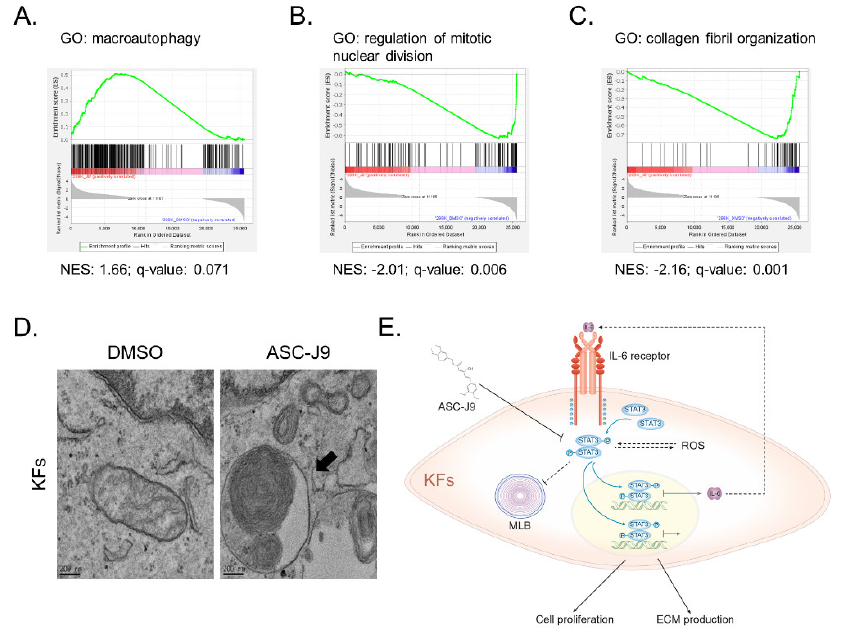
Figure 5. The formation of multilamellar bodies induced by ASC-J9 in keloid fibroblasts. ( A – C ) The biological pathways related to autophagy, cell proliferation, and ECM synthesis were identified by GSEA. ( D ) The structure of multilamellar bodies in KFs ( n = 3) treated with 10 μM ASC-J9 for 24 h was examined by TEM. ( E ) A proposed mechanism by which ASC-J9 affects the biological functions of KFs is shown. ECM, extracellular matrix; GSEA, gene set enrichment score; TEM, transmission electric microscopy; NFs, normal fibroblasts; KFs, keloid fibroblasts.